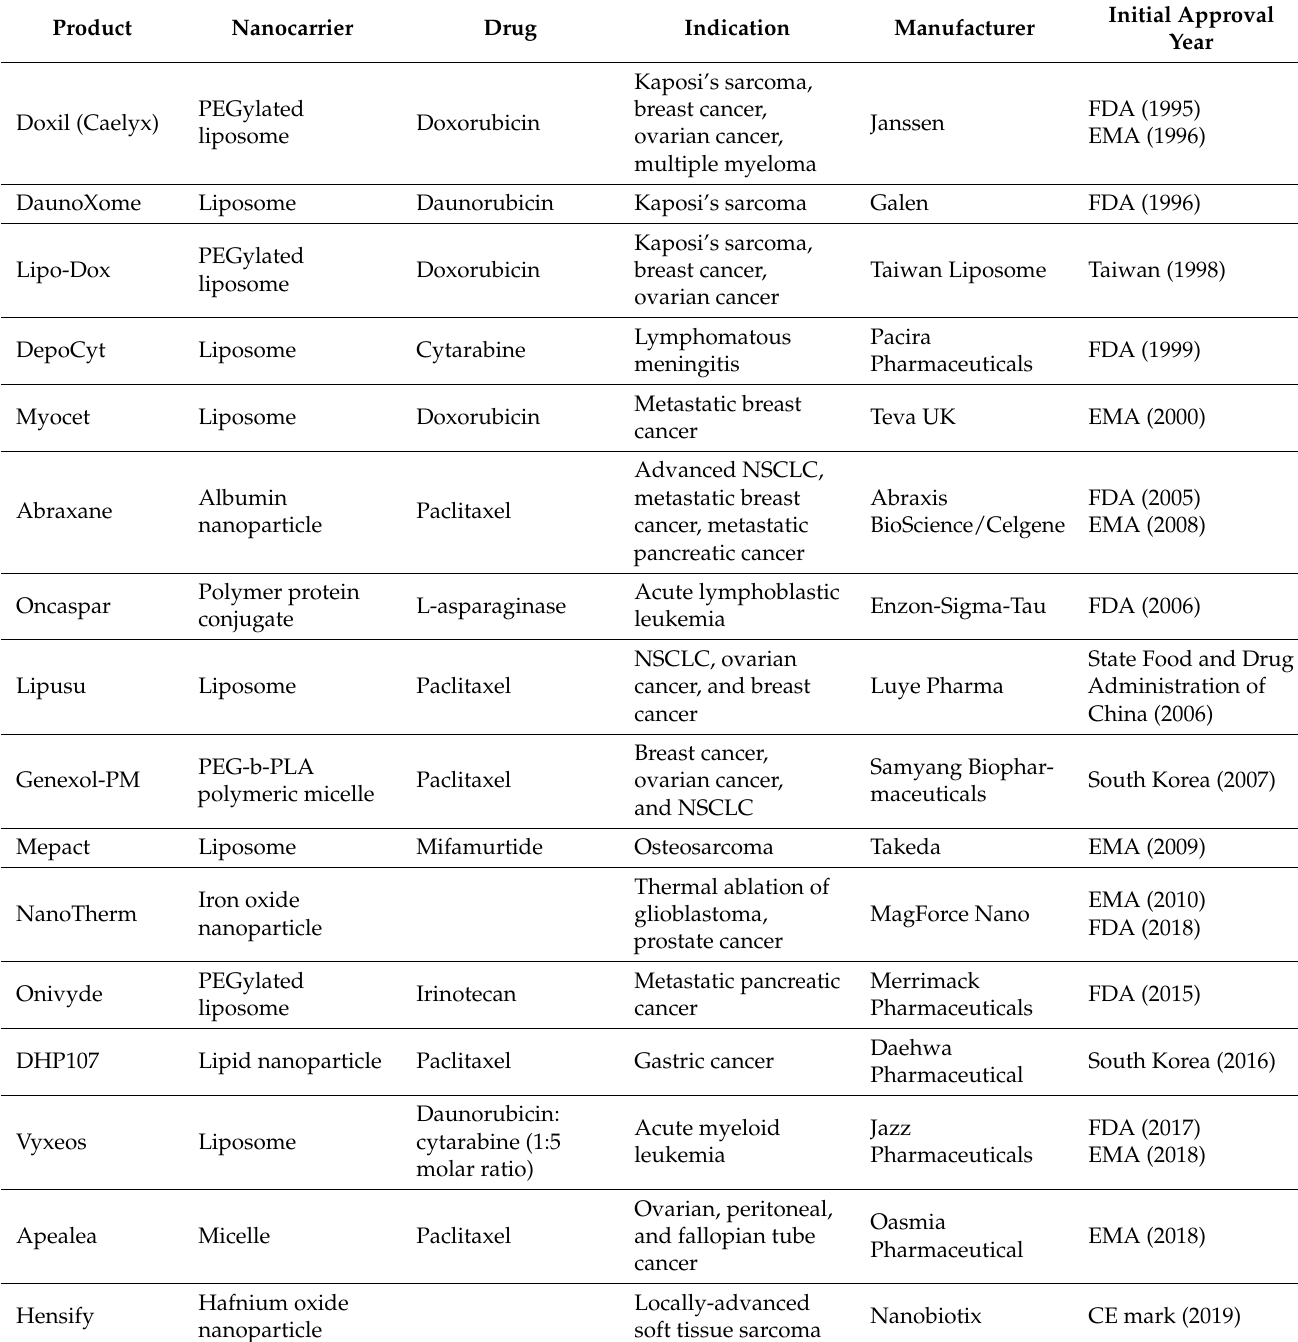
Table 2. Nanotechnology-based approved cancer